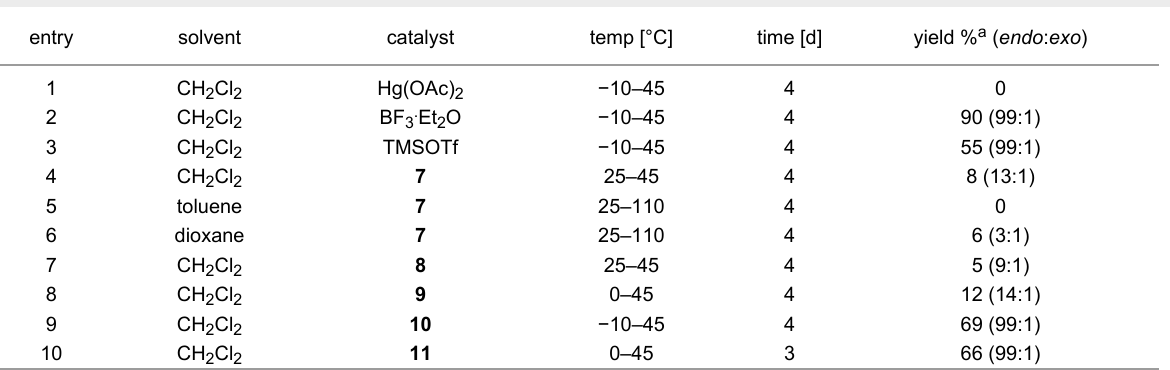
Table 1: Diels–Alder reaction with 10 mol % catalyst according to Scheme 2. Reactions with CH 2 Cl 2 were carried out in a pressure vessel.